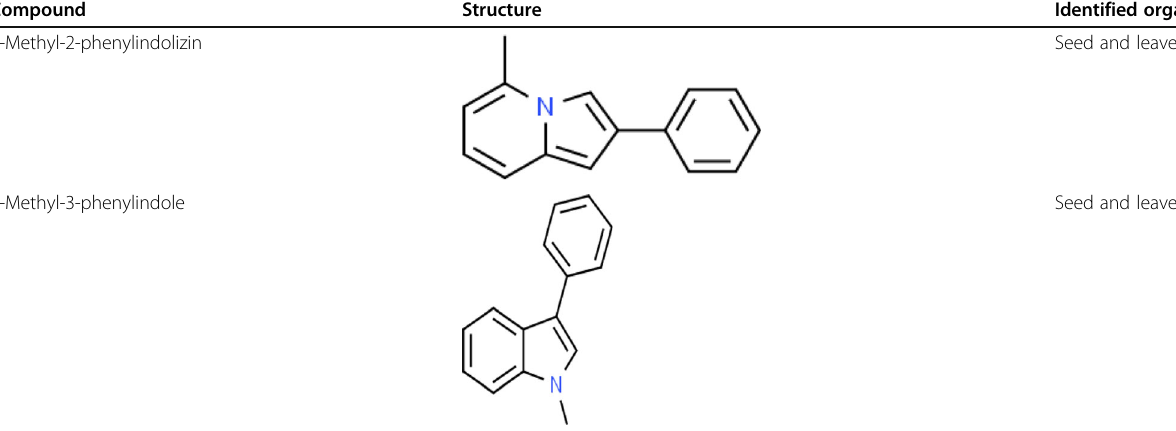
Table 4 Other compounds from morphological organs of H. umbellate (Continued)